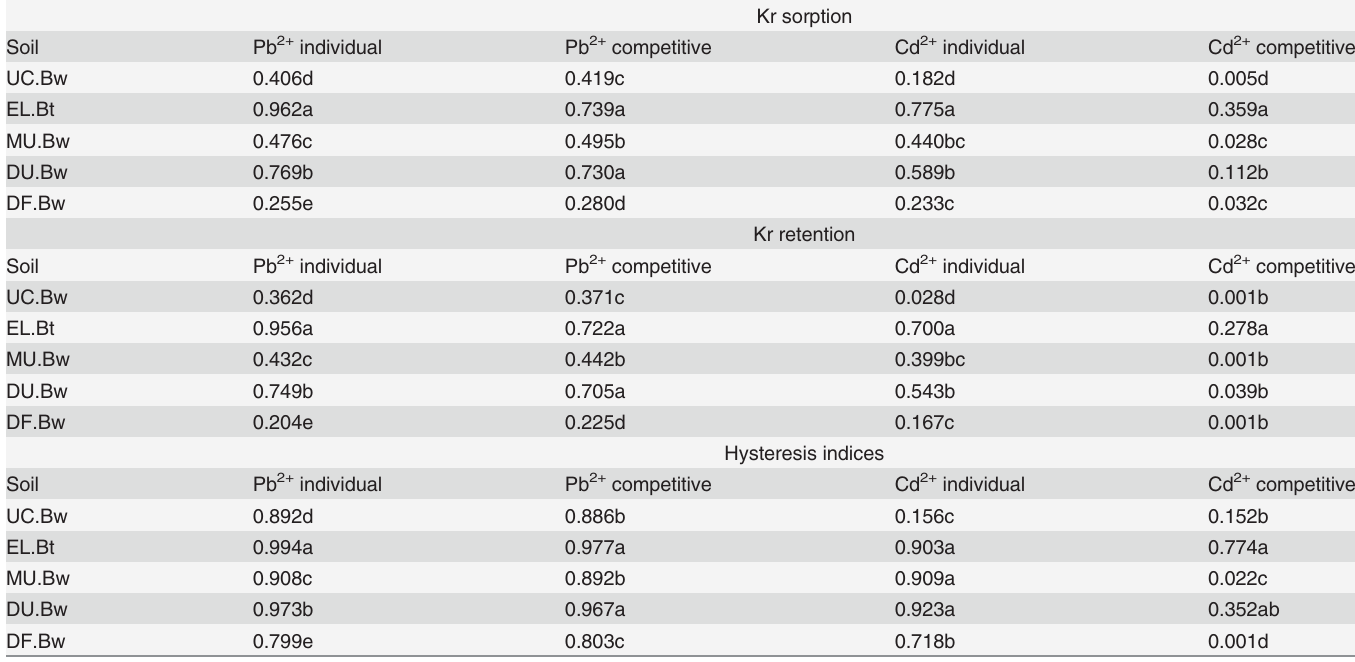
Table 2. Kr for the individual and competitive sorption and retention of Pb 2+ and Cd 2+ and hysteresis indices.